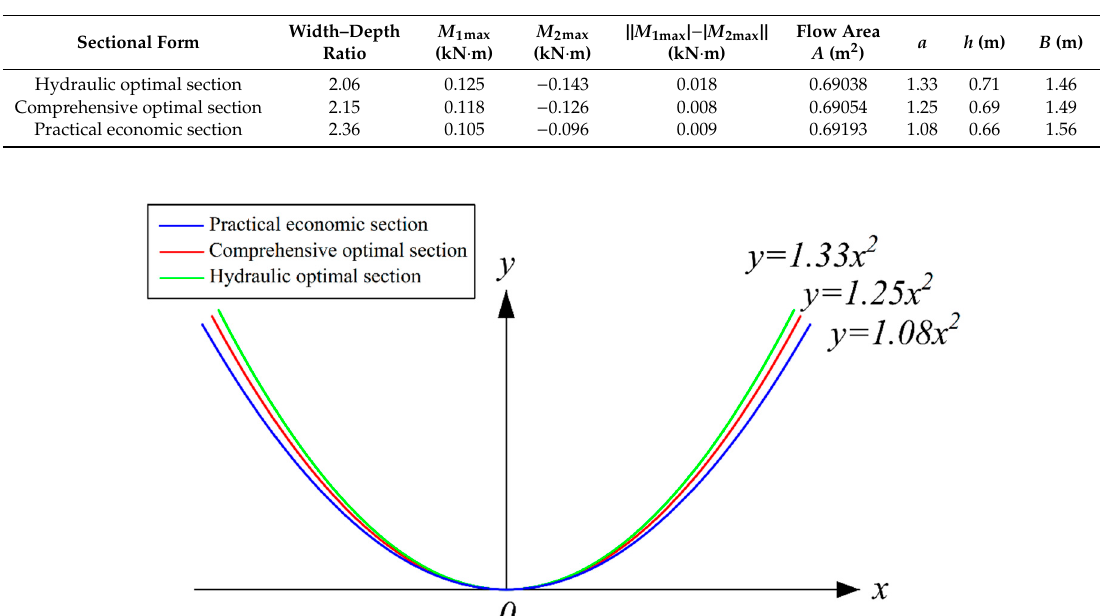
Figure 8. Three types of channel section forms.